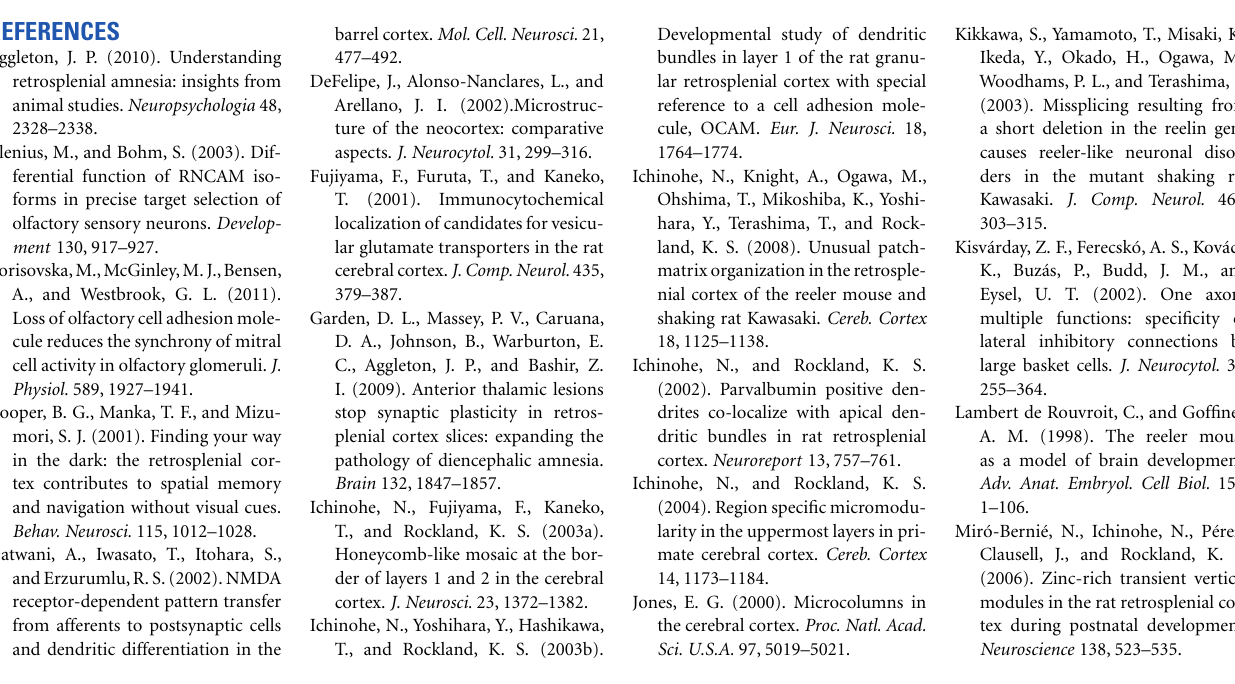
(A (cid:2) ,A (cid:2)(cid:2) ) ] show a higher magnification of the images in the white boxes [ (A (cid:2) ) from left box and (A (cid:2)(cid:2) ) from right box]. (B–E) Serial sections of a LY-filled neuron (green), double reacted for OCAM (red).The cell body is located within the OCAM-positive matrix (C) . An apical dendrite-like process gives off an oblique dendrite proximally, before entering an OCAM-negative patch. An apical tuft branches just at the border between patch and matrix compartments (C) .The basal dendrites tend, like the cell body, to stay within the OCAM-dense matrix. Scale bar: (A–E) , 50 μ m; (A (cid:2) ,A (cid:2)(cid:2) ) , 20 μ